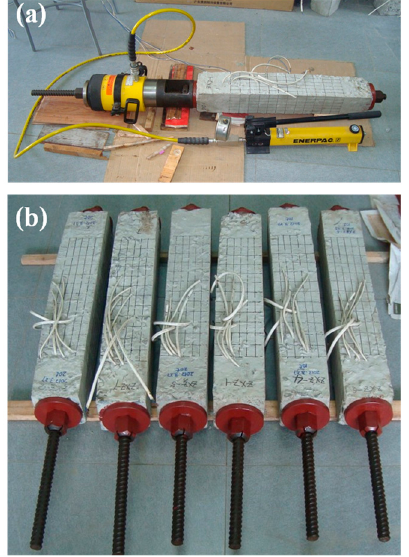
Figure 2. ( a ) Prestressing process and ( b ) preloaded column specimens.